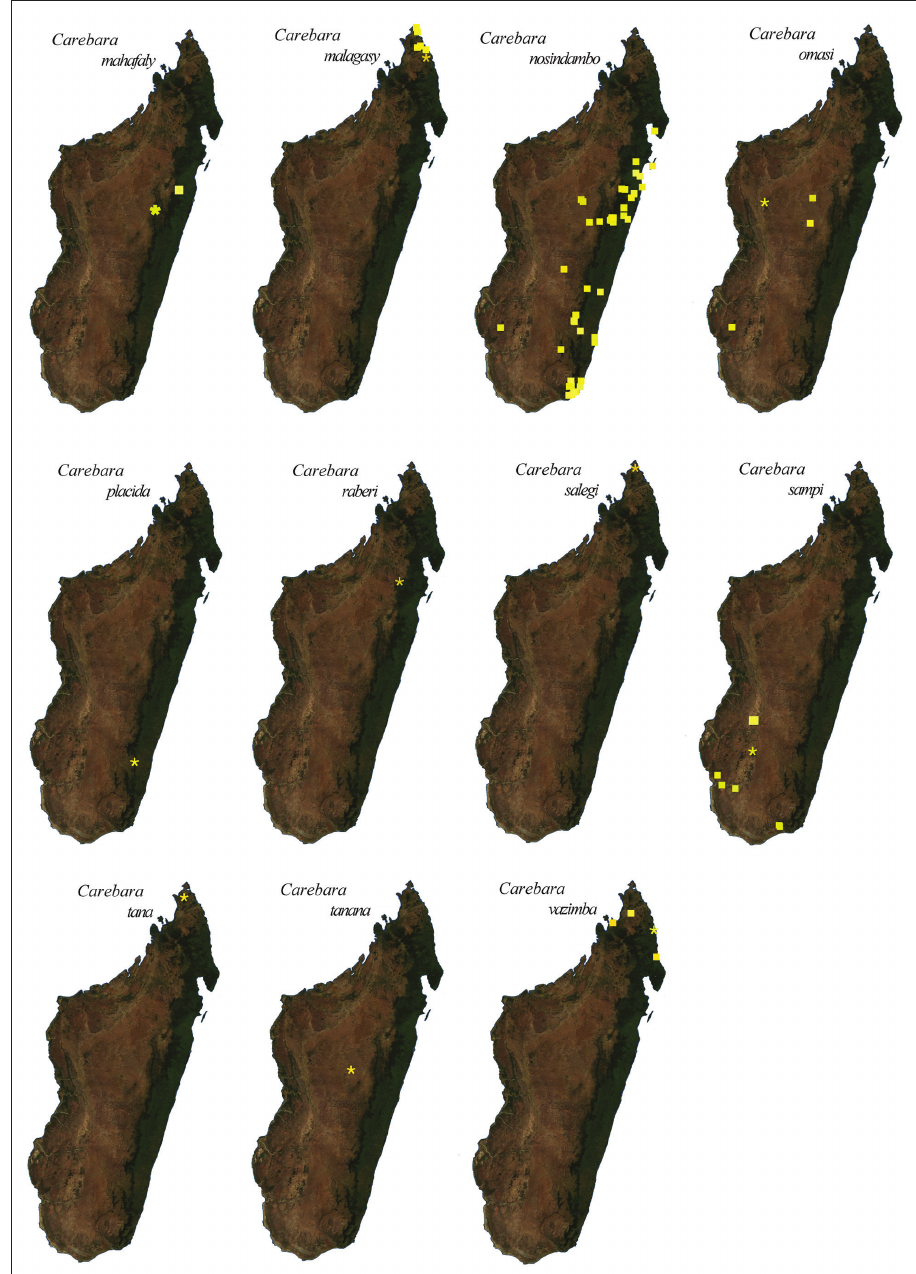
Figure 69. Distribution maps of Malagasy Carebara species: C . mahafaly , C. malagasy , C. nosindambo , C. omasi , C. placida , C. raberi , C. salegi , C. sampi , C. tana , C. tanana , C. vazimba ; type localities are indicated by